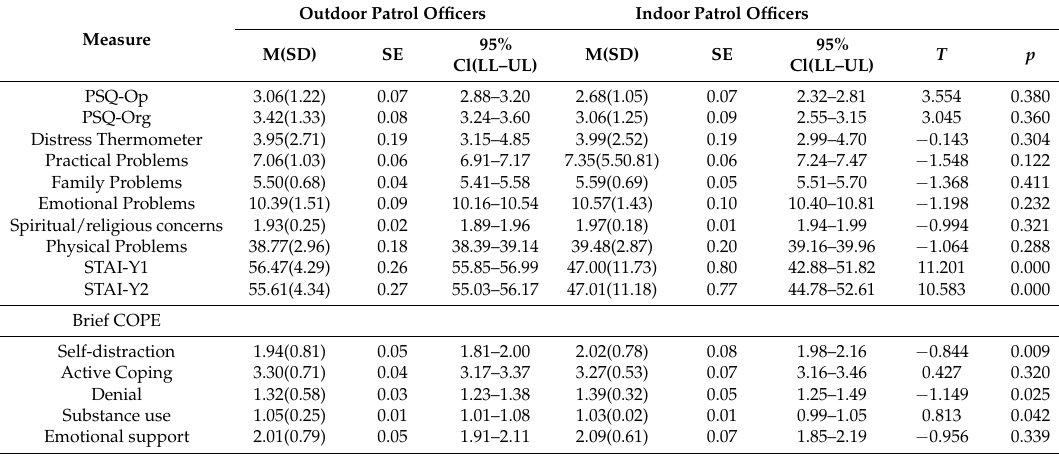
Table 1. Means, Standard Deviation, Standard Error and Confidence Interval for Scores on the PSQ-Op and PSQ-Org, Distress Thermometer, STAI Y1 and Y2 forms and Brief COPE.